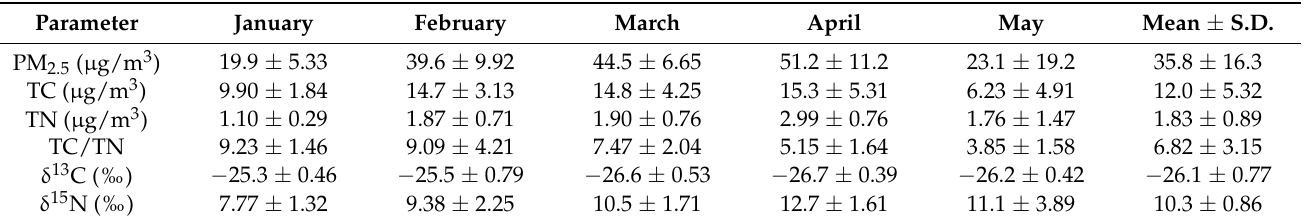
Table 1. The concentrations of TC and TN ( µ gm − 3 ), their isotope ratios (‰), and TC/TN in PM 2.5 from Chiang Mai